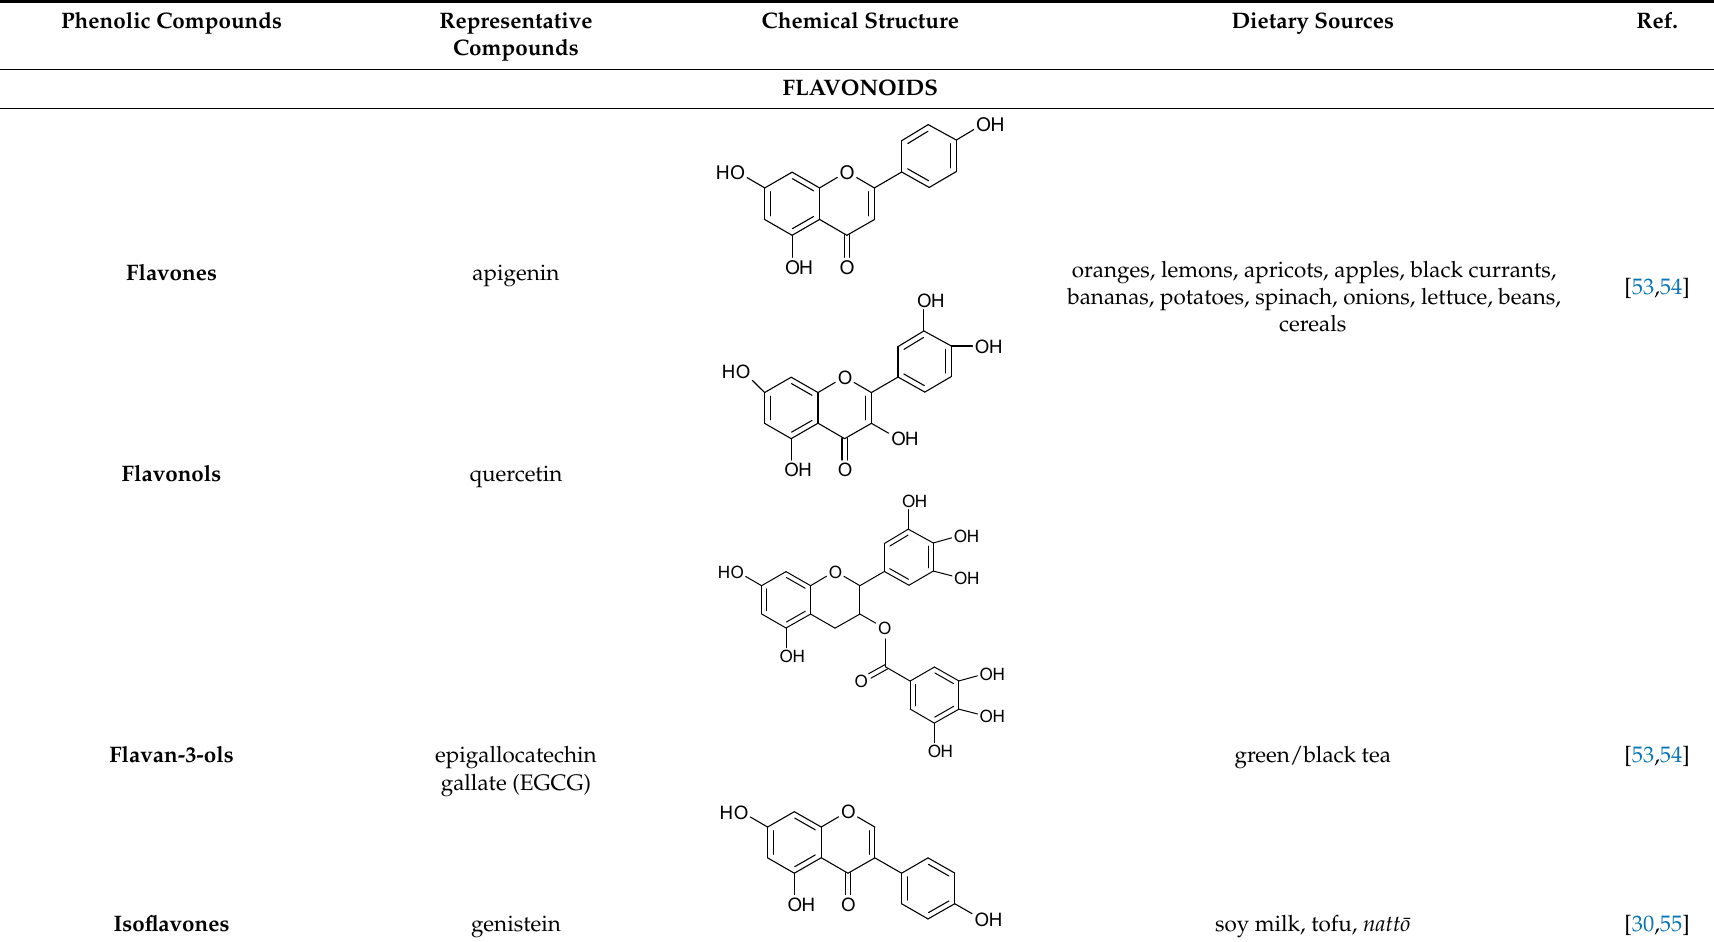
Table 1. Main classes of phenolic compounds with representative members and dietary sources frequently investigated in prostate cancer studies.